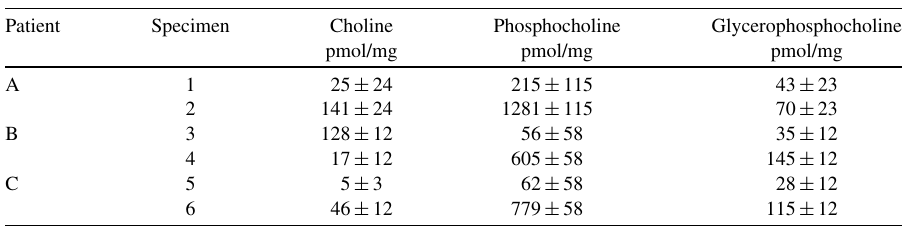
Results of LC-MS estimate of Cho and its phosphorylated derivatives concentrations. The confidence limits were derived from equation (1) of supplementary material section